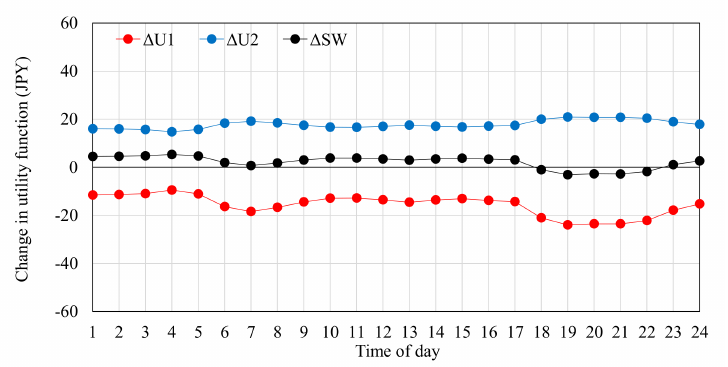
Figure 8. Changes in each function by the 1% DR request in the day of the lowest electricity consumption. In this scenario, the power suppliers could not request the DR cooperation in the target period.